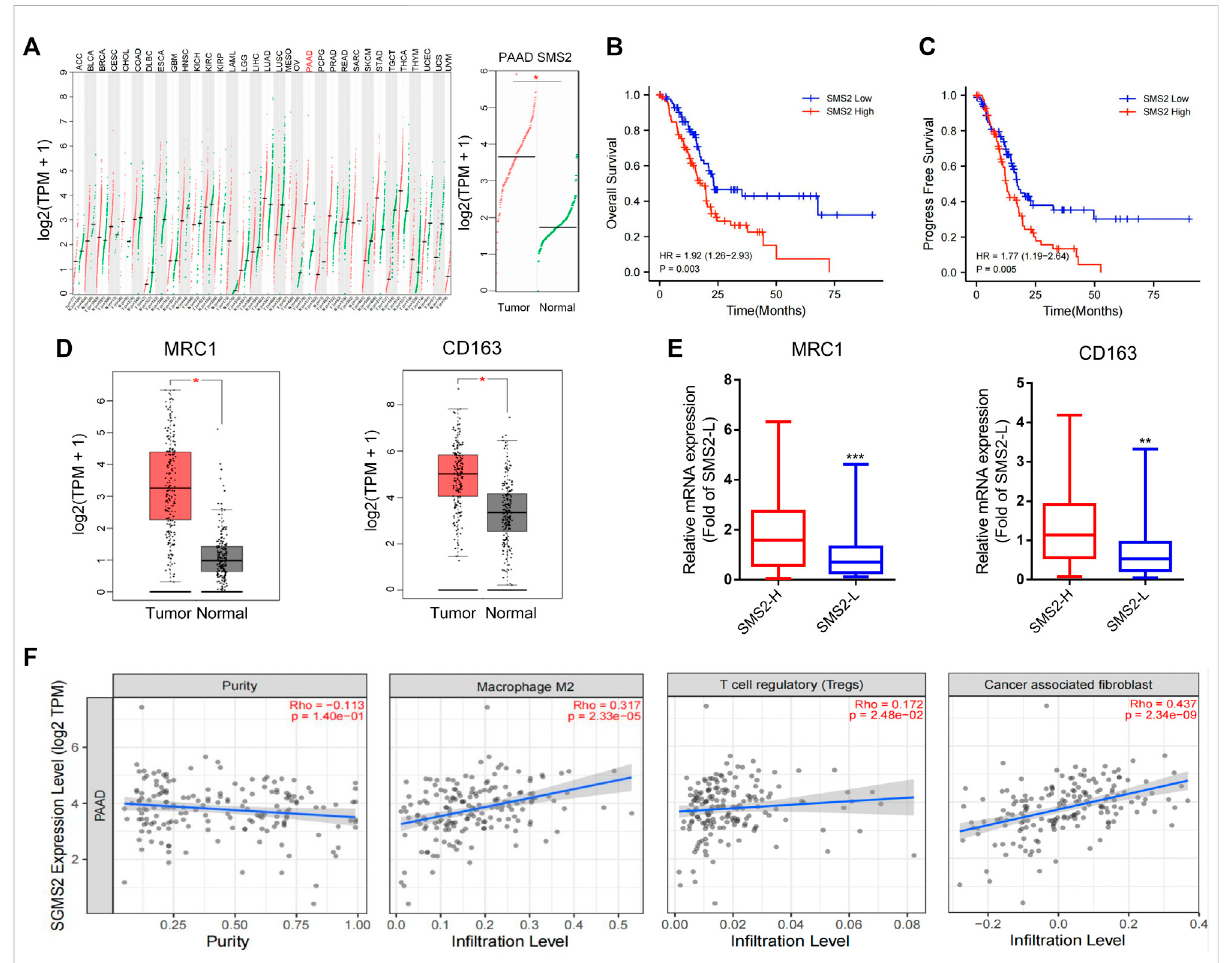
FIGURE 1 The high expression of SMS2 is related to the poor prognosis of pancreatic cancer patients. (A) . Based on data obtained from GEPIA, SMS2 is highly expressed in pancreatic cancer patients. The data of pancreatic cancer samples comes from the TCGA database. The normal samples come from the GTEX database. (B,C and E) . A total of 178 TCGA samples are divided into SMS2 High and SMS2 Low according to the median value of SMS2 expression (B) High expression of SMS2 is associated with lower overall survival rate, and (C) shorter progression-free survival. (D) . M2 polarization biomarkers MRC1 and CD163 are highly expressed in pancreatic cancer patients. (E) . High expression of SMS2 positively correlates with the expression of MRC1 and CD163. (F) . The expression of SMS2 positively correlates with the in fi ltration of M2 macrophages, Treg, CAF in pancreatic cancer. * p < 0.05; ** p < 0.01; *** p <